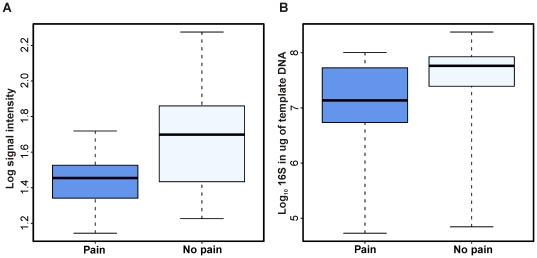
Quantification of Bidifobacteria in relation to abdominal pain.The samples were divided into two groups: with and without concurrent abdominal pain, and the abundance of Bifidobacteria in each group was determined using A. HITChip and B. qPCR. The difference between the groups was statistically significant (q≤0.02 in A; p<0.05 in B). The box extends from 25th percentile to 75th percentile, with a line at the median; the whiskers extent to the highest and lowest values.